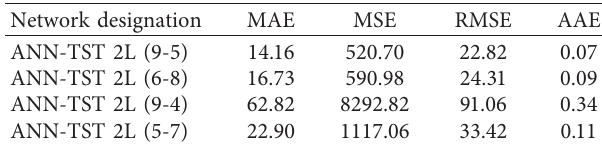
Table 4: Error metrics of the top four artificial neural networks on